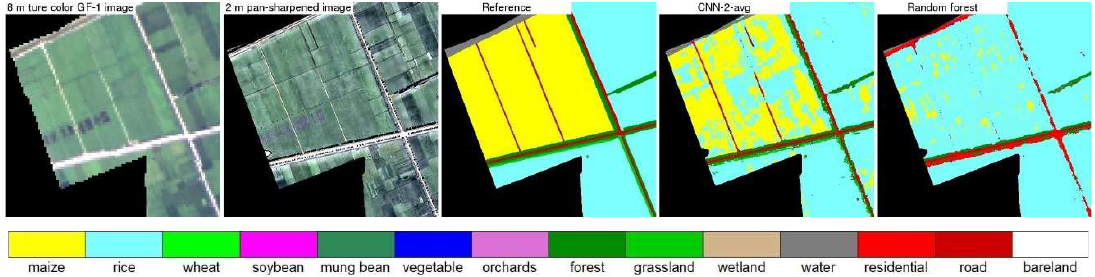
Figure 9. Same as Figure 7 but for the example 400 × 400 pixels in the box area in study area 3 (Figure 3).